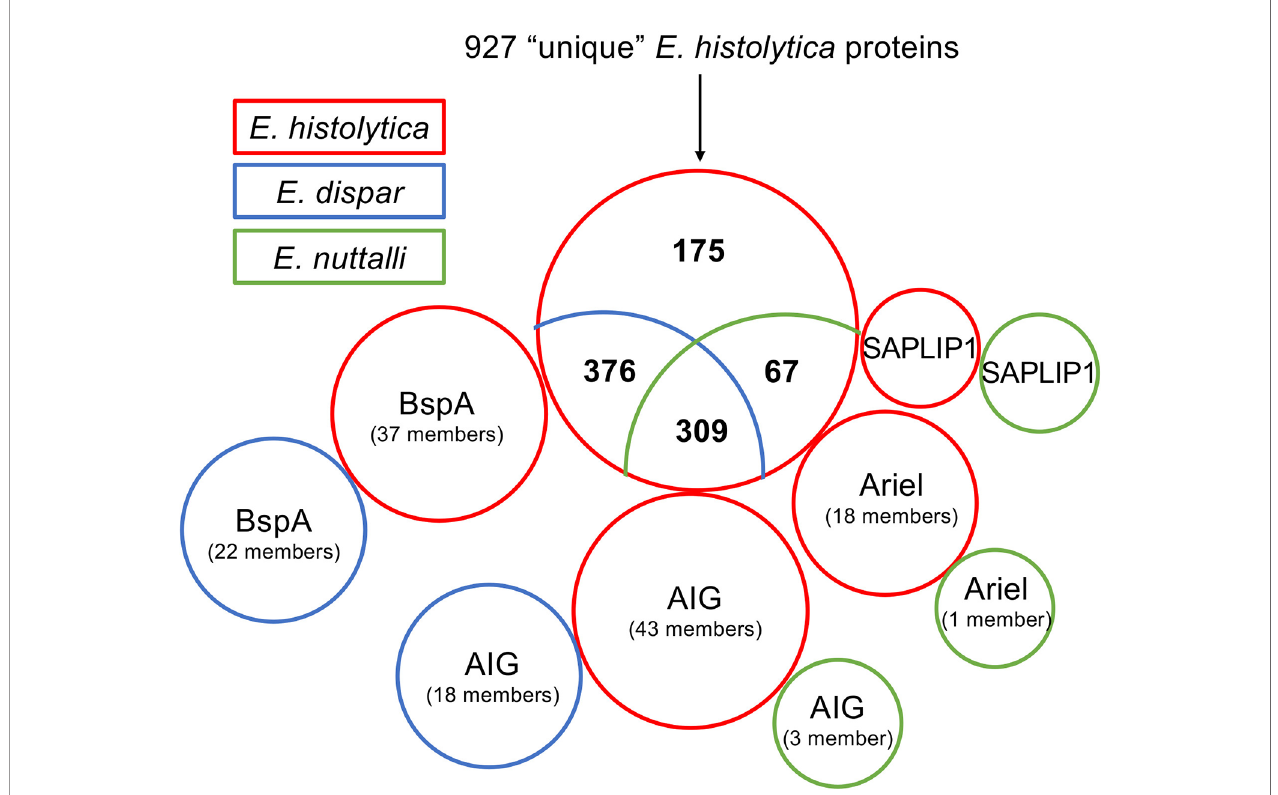
FIGURE 1 | Comparative blastp analysis of 927 proteins identi fi ed as unique for E. histolytica (Wilson et al., 2019). Shown is the comparison of E. histolytica with E. nuttalli and E. dispar as a venn diagram. The three protein families Ariel, AIG and BspA as well SAPLIP1 are shown separately. The proteins found in E. histolytica are boxed in red, those of E. dispar in blue and those of E. nuttalli in